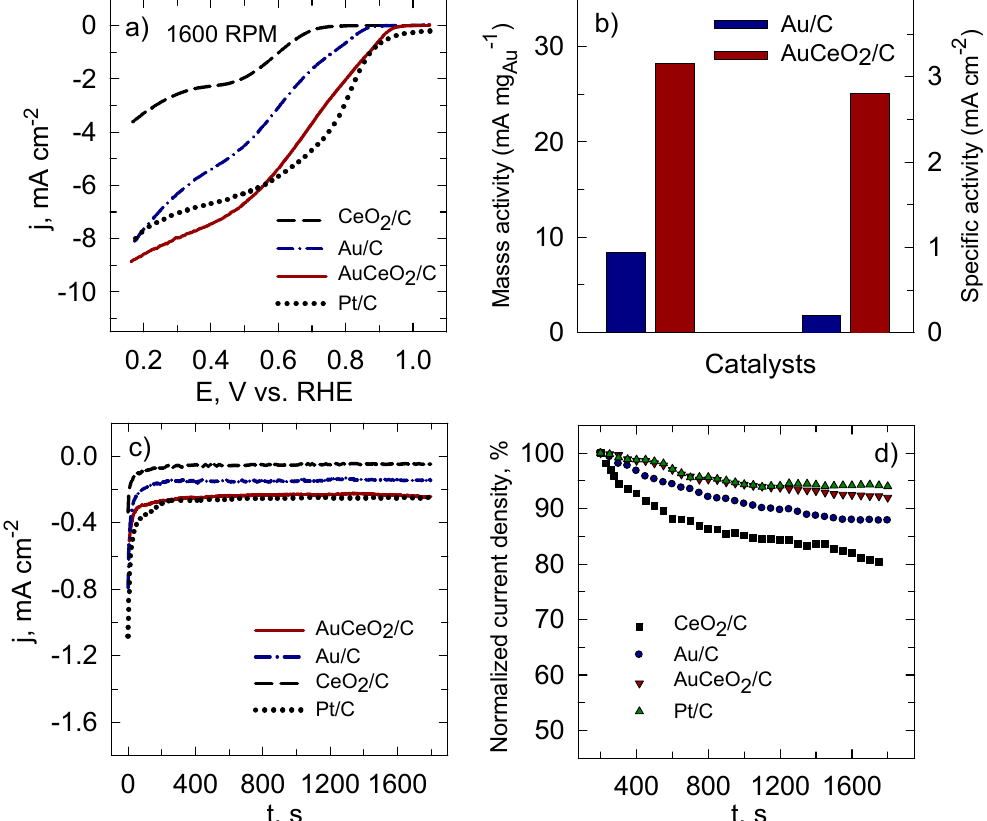
Figure 8. Comparison of linear sweep voltammetry (LSV) curves recorded on the CeO 2 /C, Au/C, AuCeO 2 /C, and Pt/C catalysts in an O 2 -saturated 0.1 M NaOH solution at 1600 rpm ( a ); LSV oxygen reduction current densities at 0.8 V normalized by Au loadings and electrochemically active surface areas (ESAs) of AuNPs for the Au/C and AuCeO 2 /C catalysts ( b ); chronoamperometric curves recorded on the investigated catalysts at 0.55 V in an O 2 -saturated 0.1 M NaOH solution ( c ); chronoamperometric responses (percentage of current density retained vs. operation time) of all the catalysts ( d ).